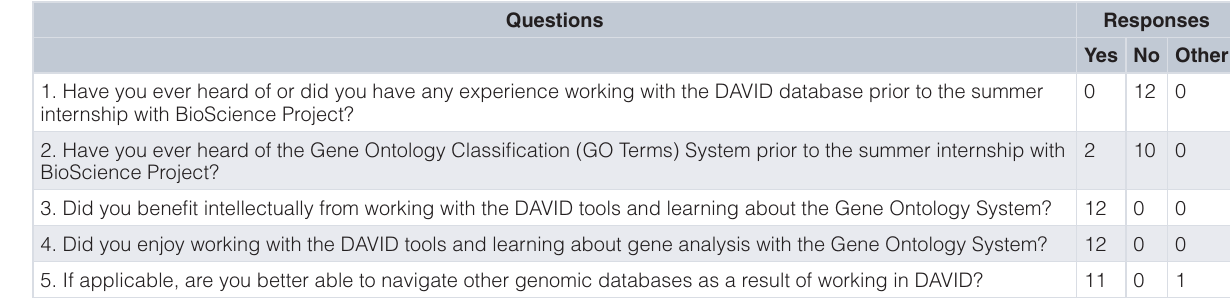
Table 1. DAVID and GO Student Survey.